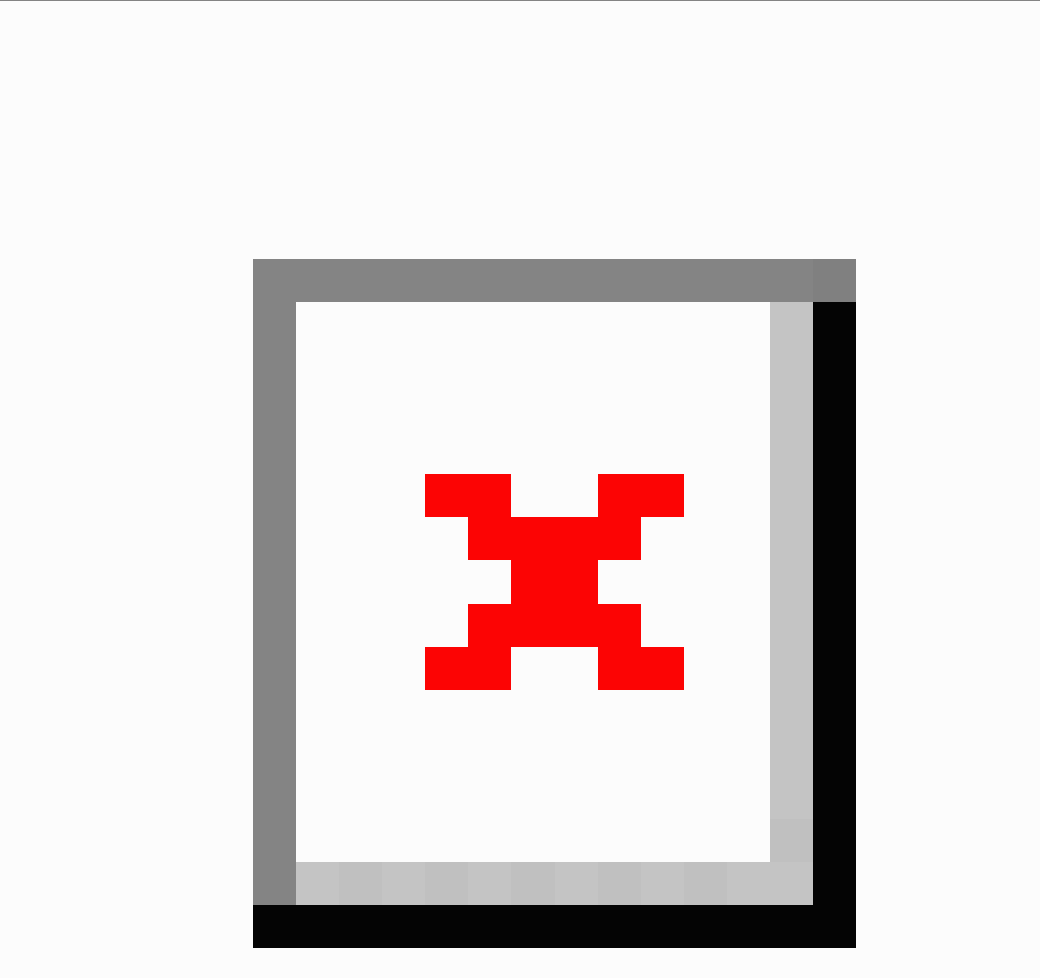
Figure 2. Characteristics of aortic pathology, including kind of pathology, kind of examination, details about the pathology, and surgery details with potential